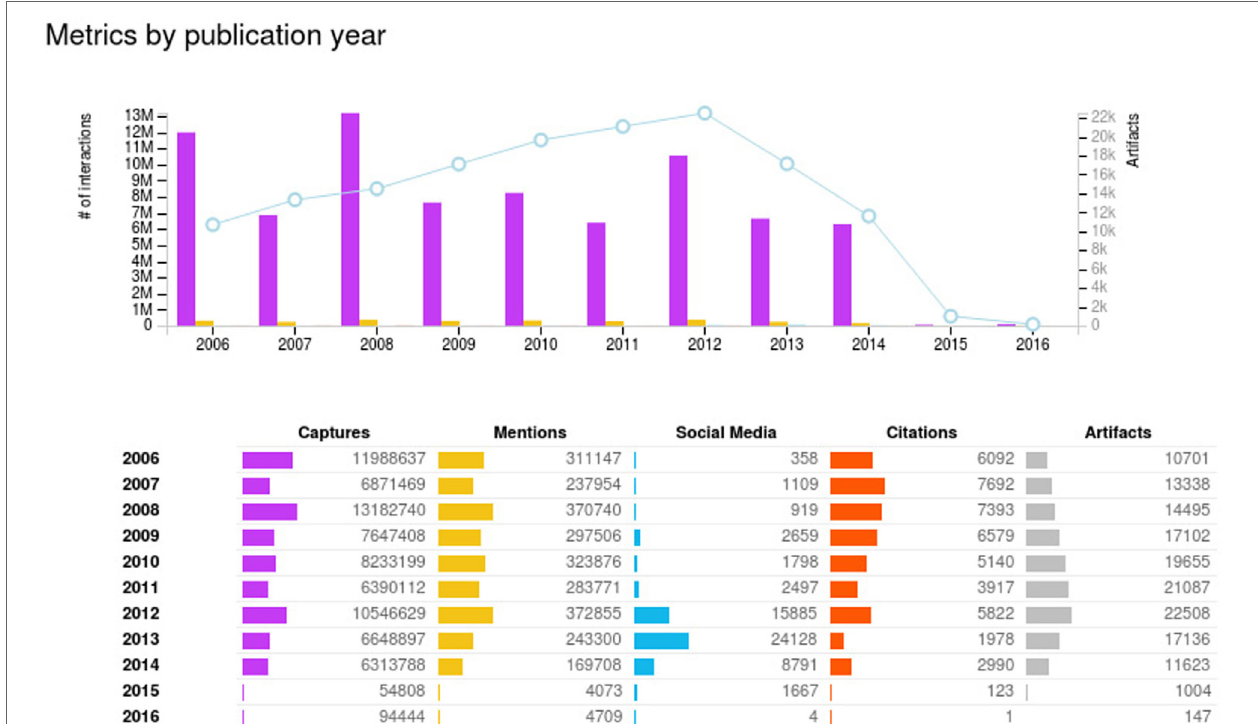
FigUre 1 | Dimension scores by publication year in PlumX and its PDF Export